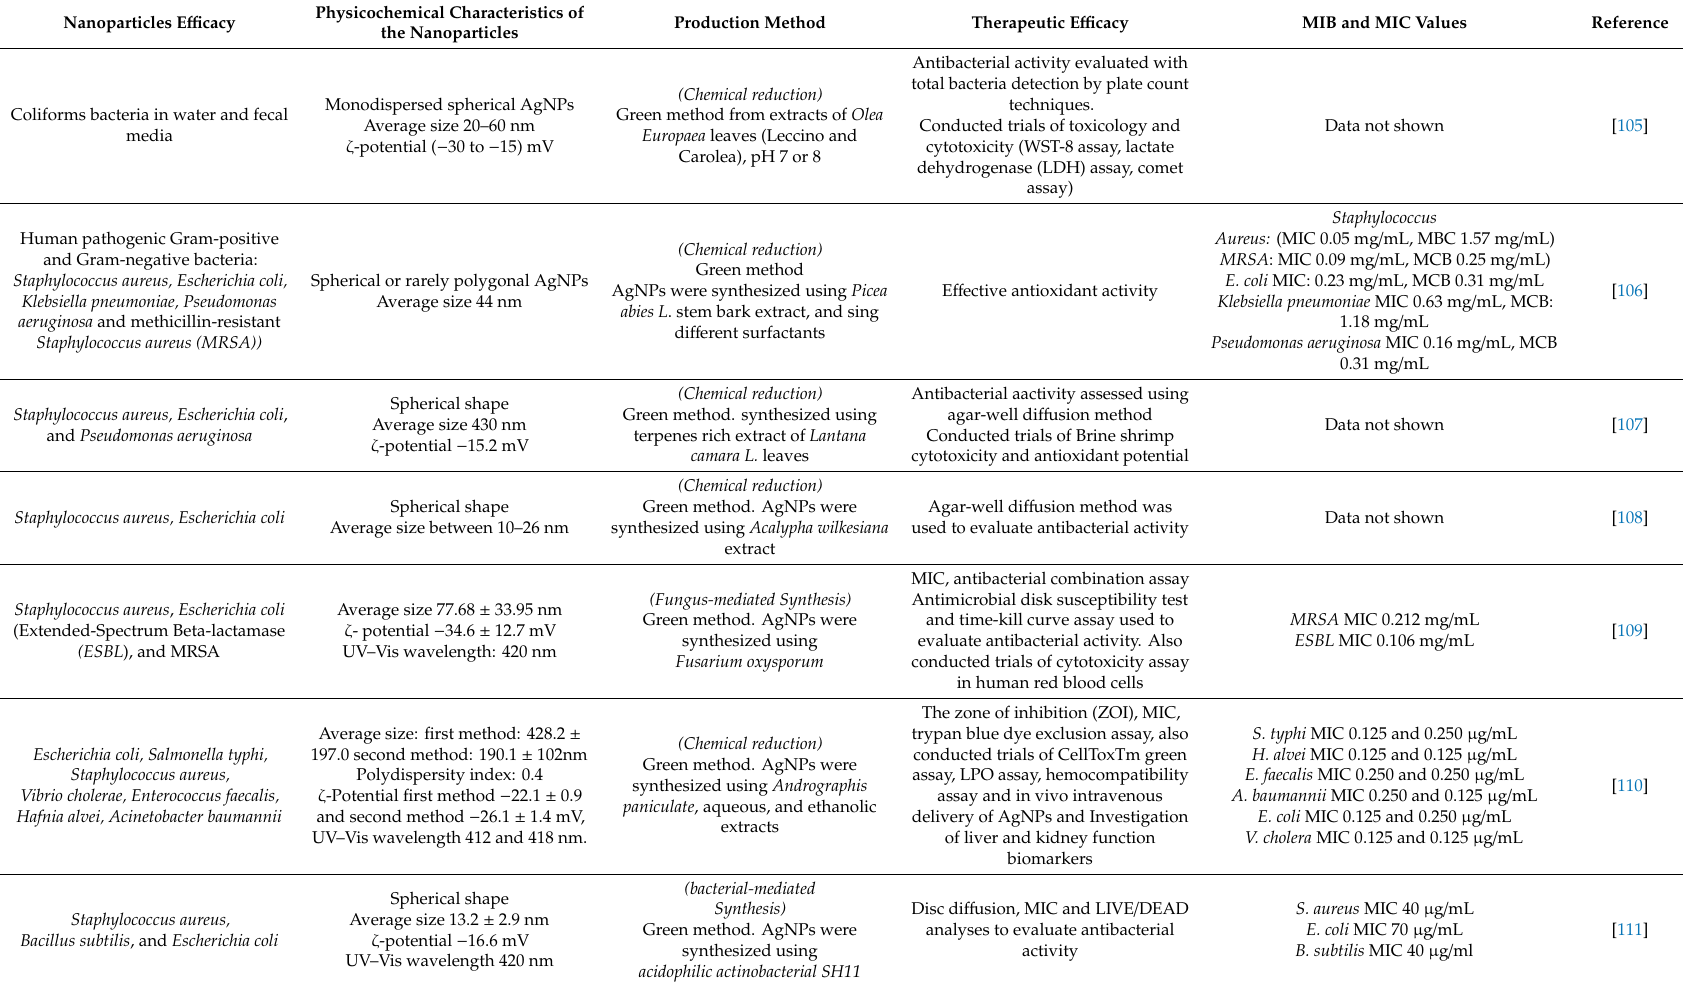
Table 2. Antibacterial applications of silver-based nanoparticles, with respective mminimum inhibitory concentration (MIC) and minimum bactericidal concentration (MBC)